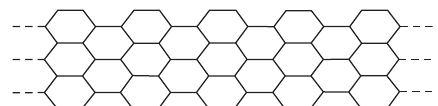
Figure 2: The 3D lattice of the zigzag TUZC